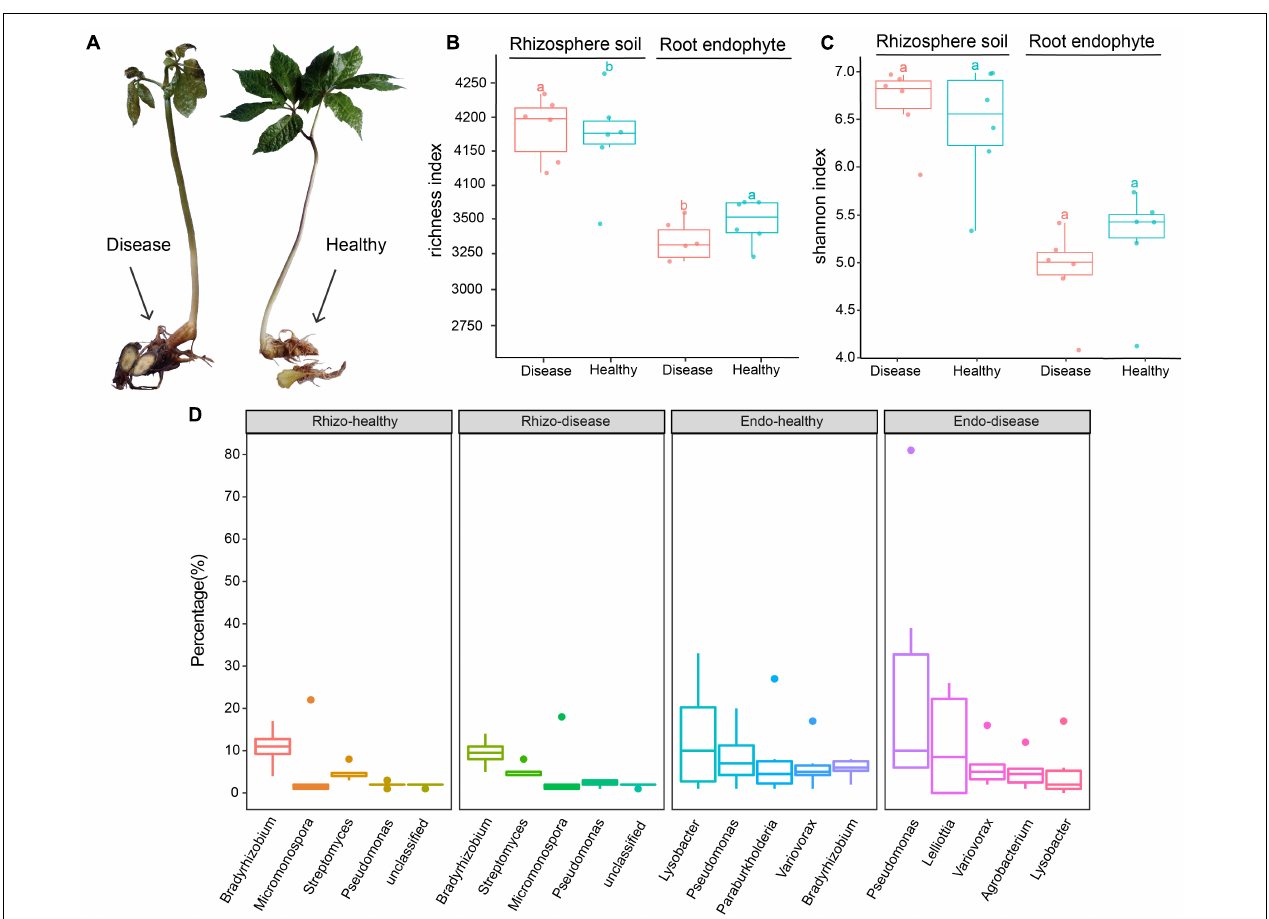
FIGURE 1 | Characteristics of healthy and root rot diseased Panax notoginseng plants. (A) Diseased and healthy P. notoginseng plant parts. (B) Observed OTUs box plot based on the rhizosphere soil and root endophyte bacteria species abundance. (C) Shannon index box plot based on the rhizosphere soil and root endophyte bacteria species abundance. (D) Boxplots of the top five species in each of the rhizosphere soil and root endophyte groups. Tukey’s HSD test is used to compare the differences between two groups and add the difference group letters.